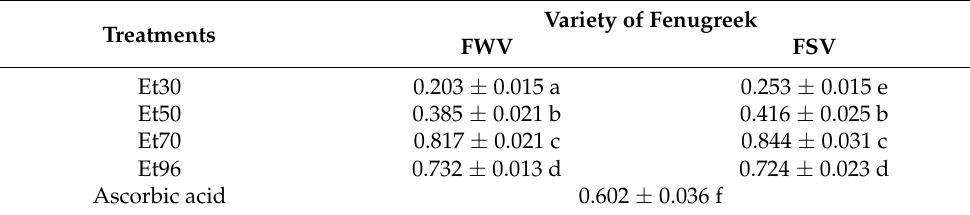
0.602 ± 0.036 f Values shown are means ± standard error. Values within columns and between the extracts of the two varieties bearing same letter are not significantly different ( p < 0.05). Treatments: Et30 = extract with 30% ethanol; Et50 = extract with 50% ethanol; Et70 = extract with 70% ethanol; Et96 = extract with 96% ethanol.